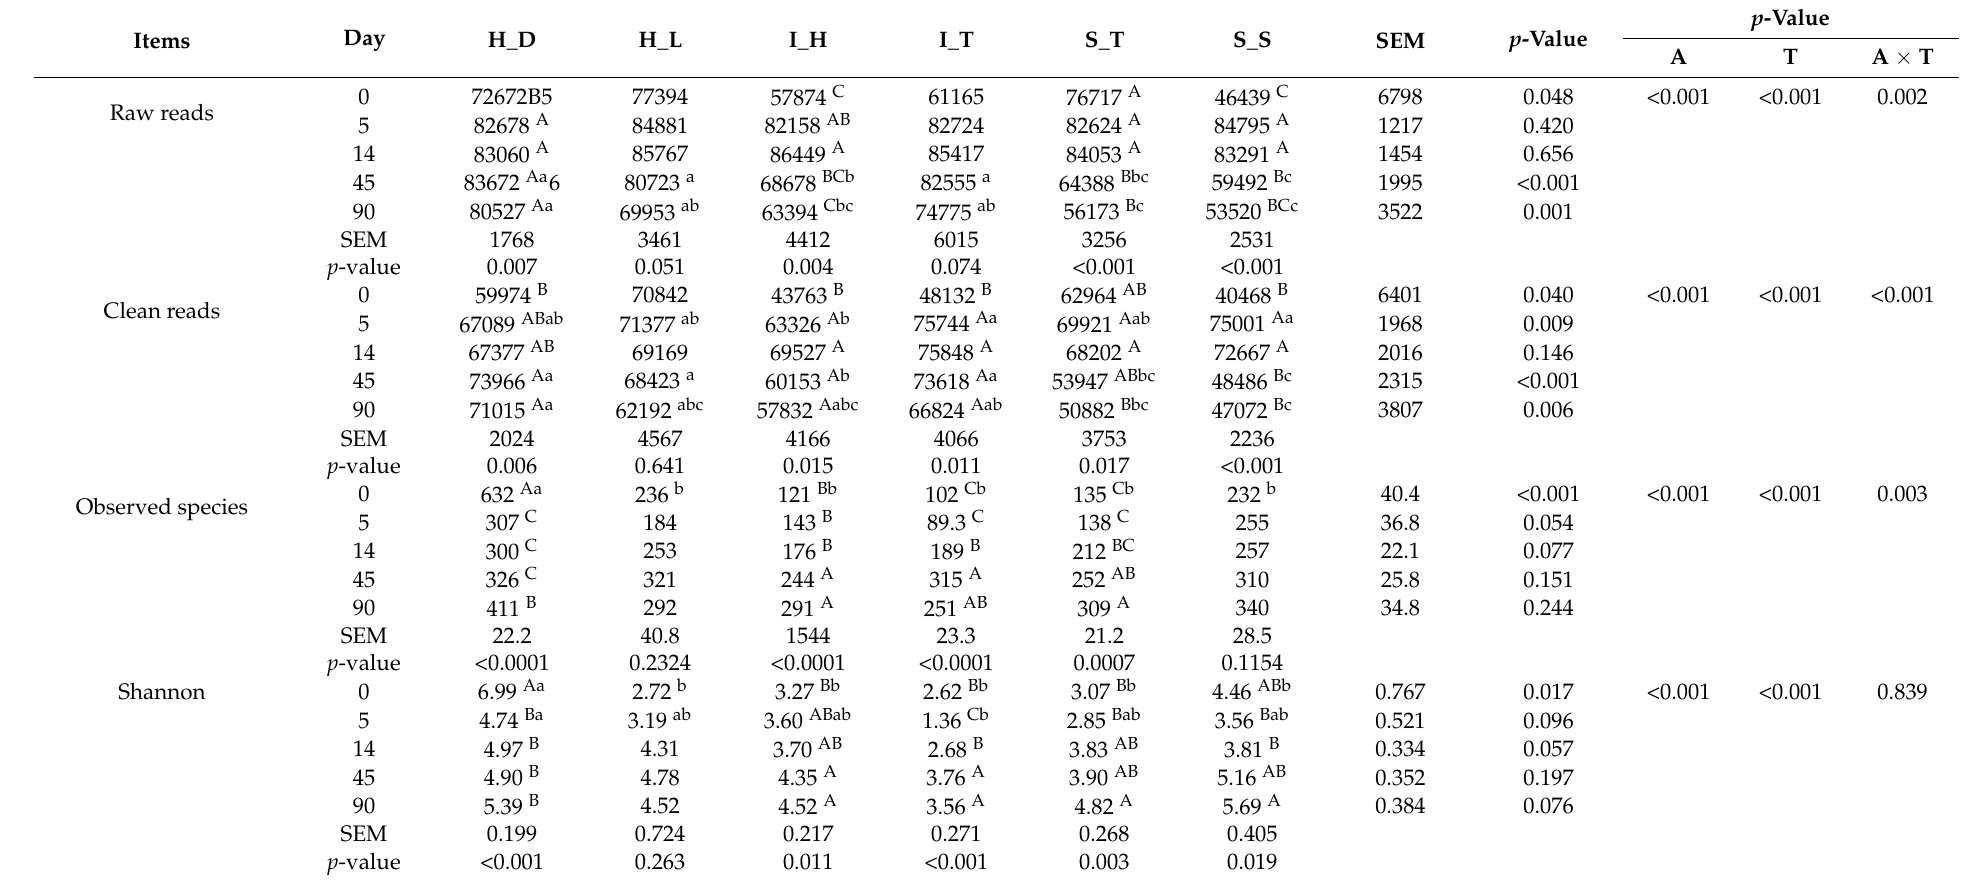
Table 3. Sequencing data and alpha diversity of bacteria and fungi in whole-plant corn silage during fermentation ( n =